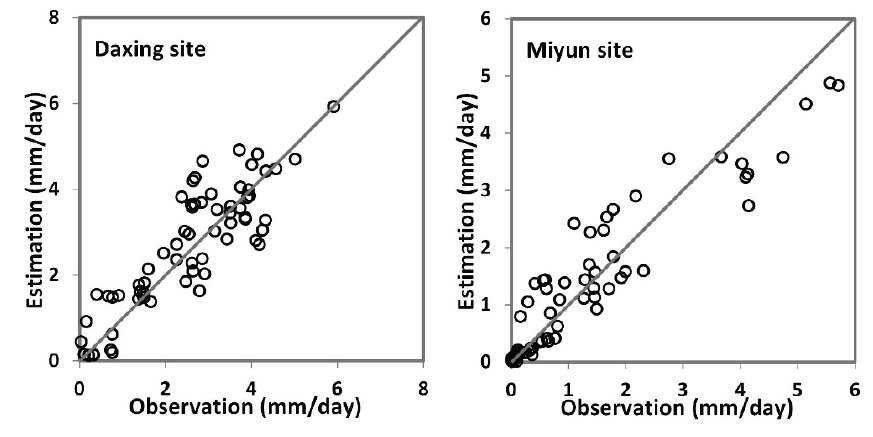
Figure 7. The comparisons of clear-sky daily ET estimates from the optimum method with LAS